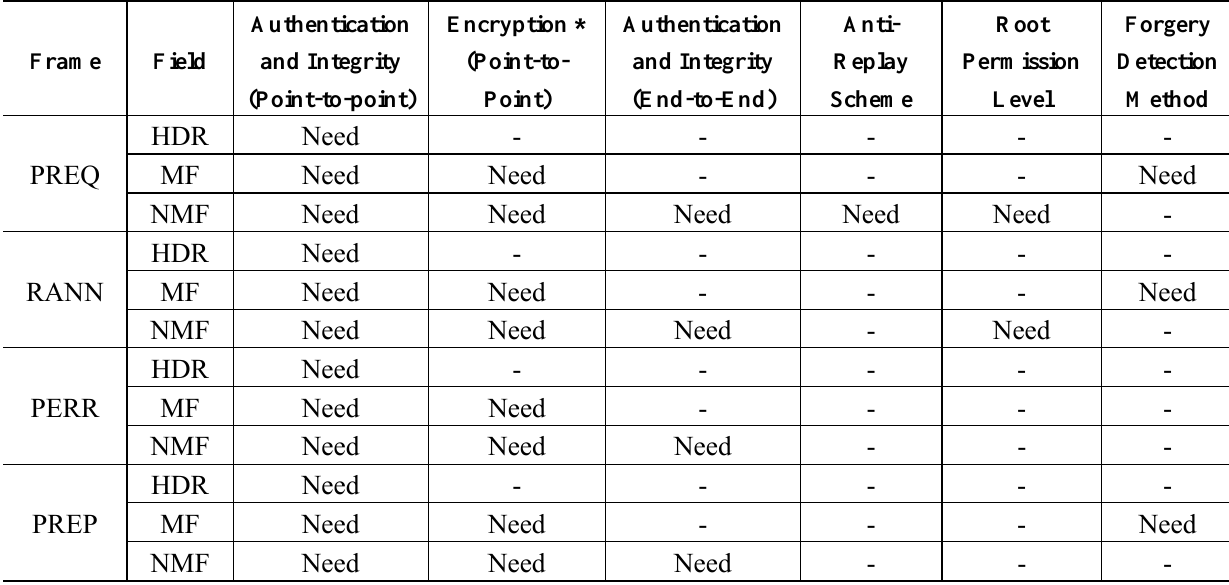
Table 9. Security service requirements according to the relevant frames and fields